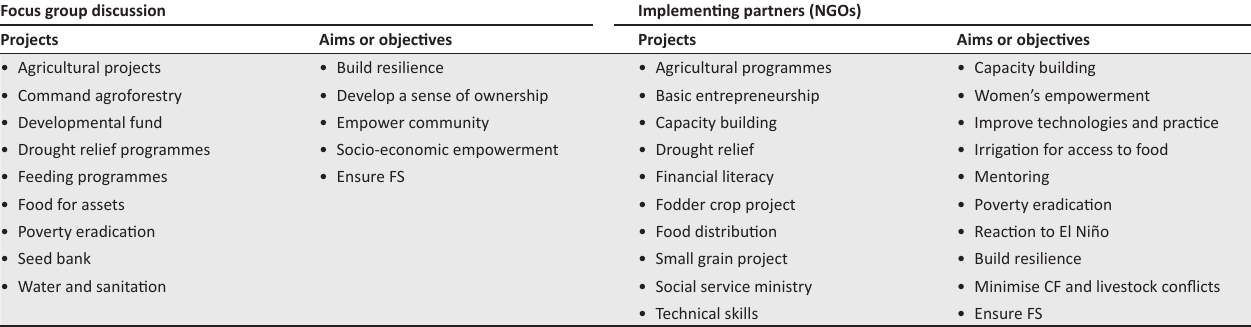
TABLE 1: Implemented projects and aims or objectives. Focus group